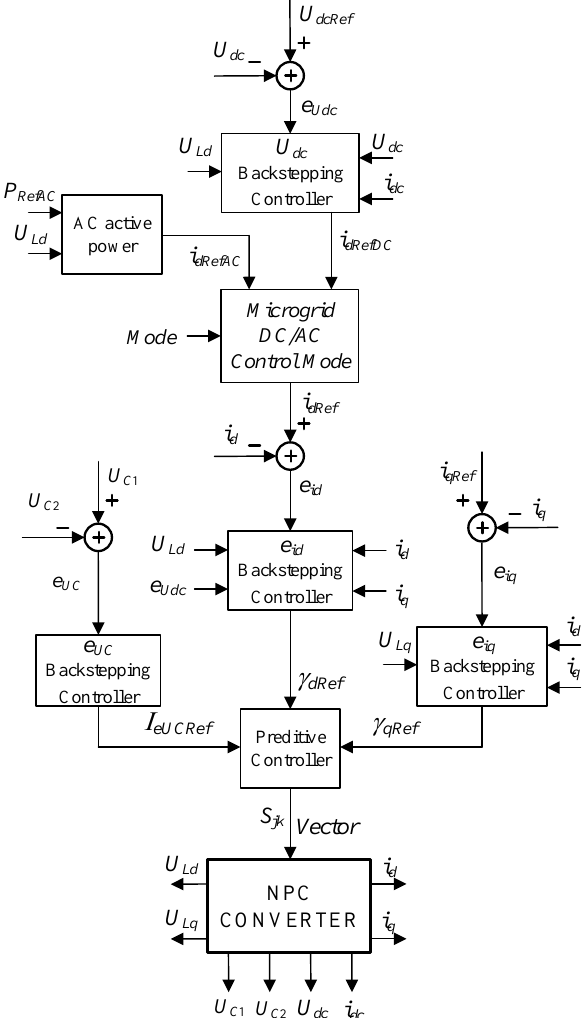
Figure 5. Hybrid microgrid AC/DC BP control diagram.